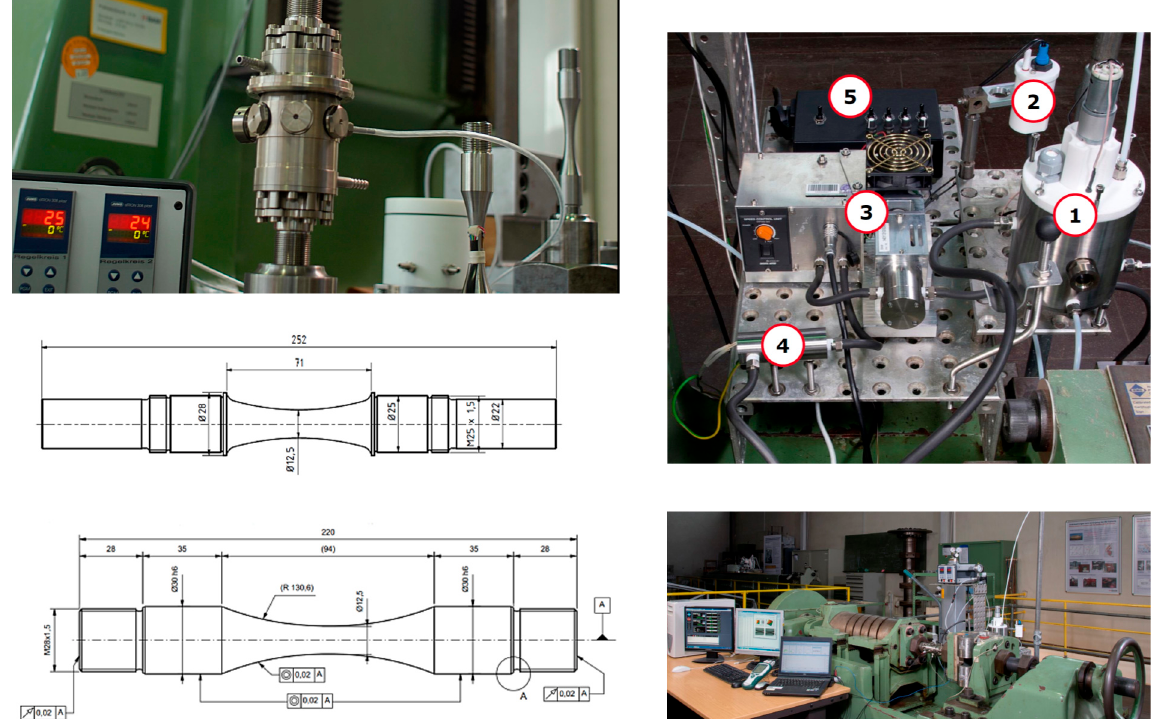
Figure 2. Test setup for horizontal corrosion fatigue tests ( top, right ). Horizontal resonant testing machine ( bottom, right ), periphery with gear pump, reservoir and measuring units ( top, right ), test specimen ( bottom left ), (1: Reservoir, 2: Temperature control unit, 3: Magnetically driven gear pump, 4: Heating element, 5: Control unit).